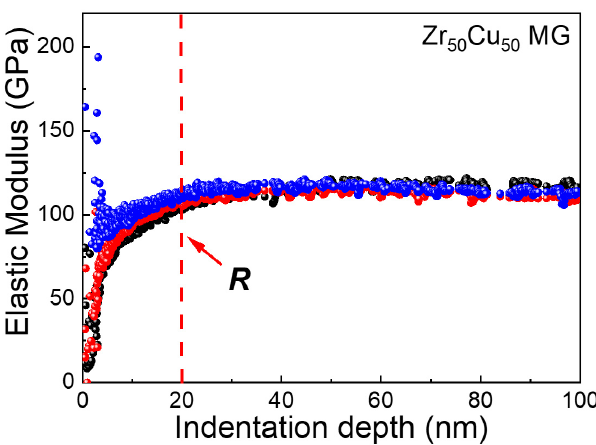
Figure 6. Elastic moduli of the Zr 50 Cu 50 metallic glass sample as a function of indentation depth during nanoindentation using the continuous stiffness measurement technique. The sample data were from three independent nanoindentation tests showing good reproducibility. The vertical dashed line marks the radius of the Berkovich indenter tip curvature value R .